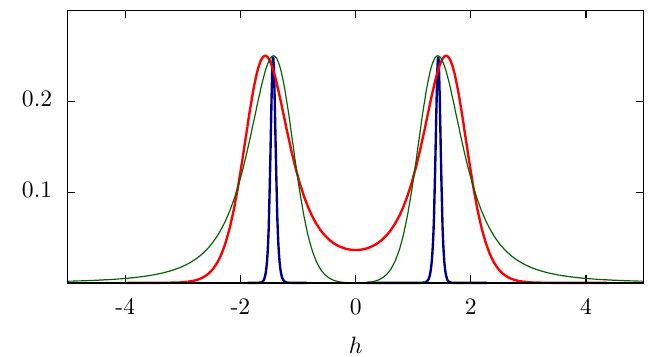
( h ) ρ ( h ) ρ ( h ) as in formula (79) which corresponds to the weight Figure 4: Plot of ( 2 π ) 2 ρ p h t of the zero momentum one particle-hole excitations. The plot is done for coupling constant c = 1 and n = 1 and for a state at temperature T = 0.1 (blue line), T = 1 (red line) and the GGE state given by the BEC quench (green line). At small T (blue line) only excitations performed at the edges of the Fermi sea (the so called Fermi points) have a finite weight. As the state acquires temperature (red line) or in general entropy, as in the BEC state (green line), zero momentum excitations can be created in much wider window of h . Therefore states with larger entropy have larger values of S ( 0 ) , as shown in Fig.